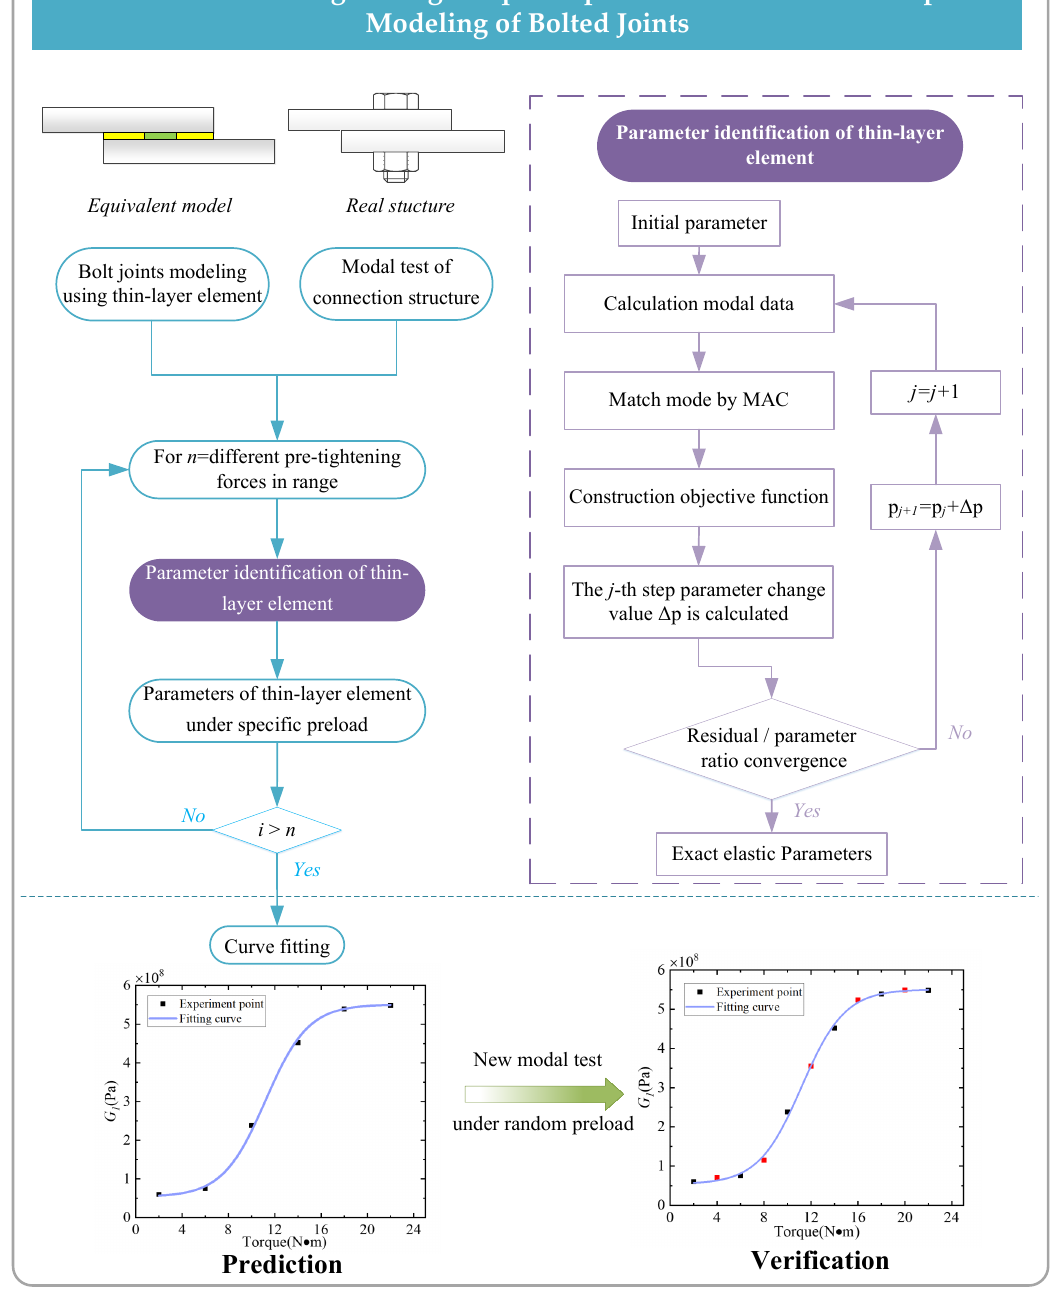
Figure 4. The flowchart for the parameter identification method of bolted joints under different pre‐tightening